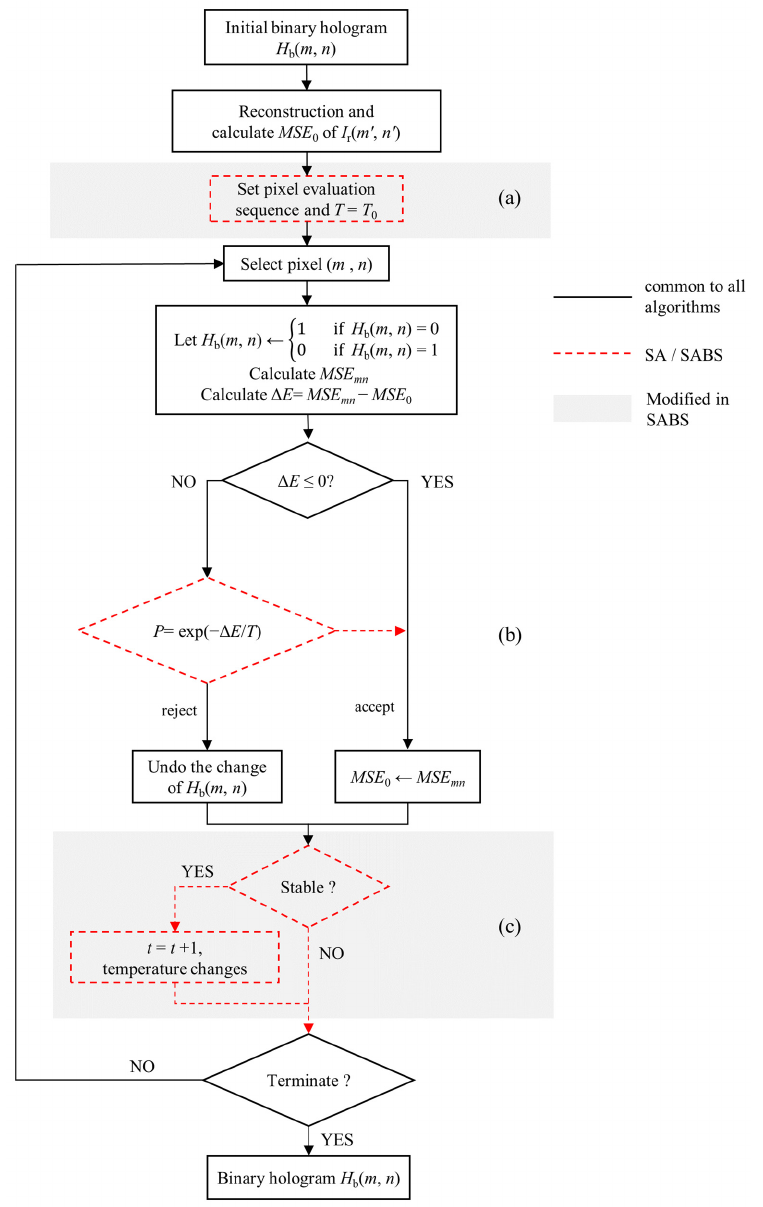
Figure 1. Flowchart of direct binary search (DBS), simulated annealing (SA), and simulated annealing binary search (SABS).